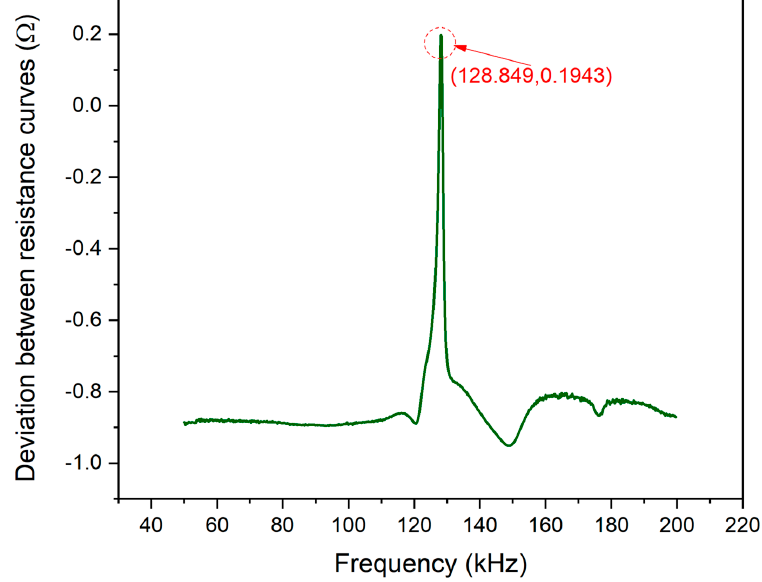
Figure 11. Resistance signal deviation between experimental and theoretical curves of PZT#2.